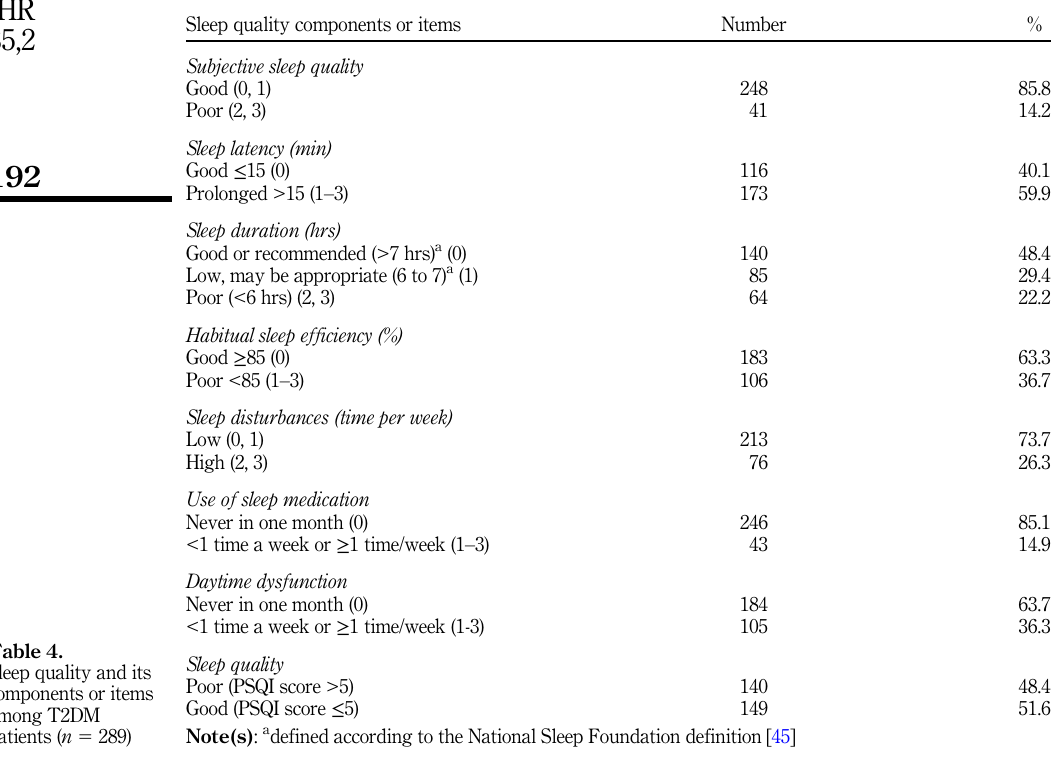
components or items among T2DM patients ( n 5